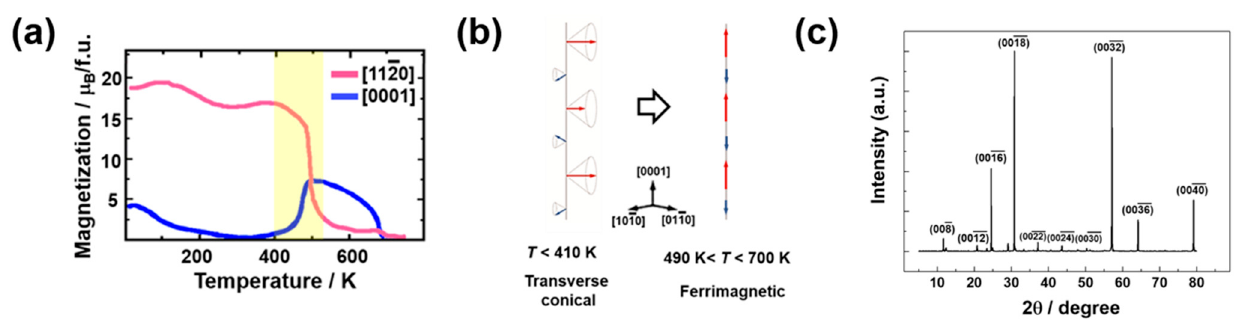
(cid:2) (cid:3) 1120 and [0001] directions measured at